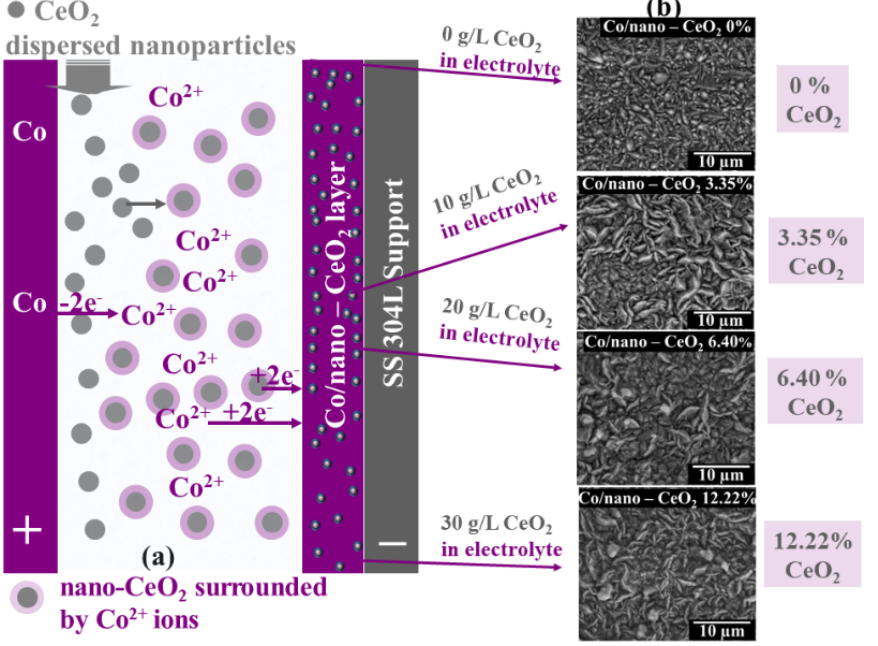
Figure 2. Schematic of nano-CeO 2 electrocodeposition into cobalt matrix to obtain Co/nano-CeO 2 nanostructured layers: ( a ) electrochemical cell with an SS 304L cathode on which the pure cobalt and nanostructured layers were electrodeposited, a cobalt sheet as the anode, a cobalt electrolyte with Co 2+ ions, and dispersed nano-CeO 2 particles, which were surrounded by ions from the solution after the immersion; ( b ) SEM micrographs of pure cobalt and Co/nano-CeO 2 nanostructured layers obtained at different concentrations of dispersed CeO 2 nanoparticles in the electrolyte, and having a different wt. percent of CeO 2 embedded into the cobalt